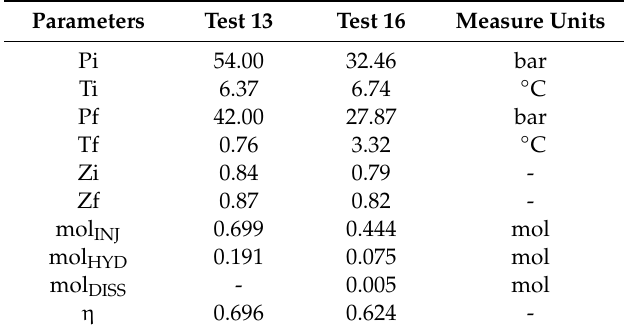
Table 7. Parameters related to Test 13 (with CH 4 ) and Test 16 (with CO 2 ).